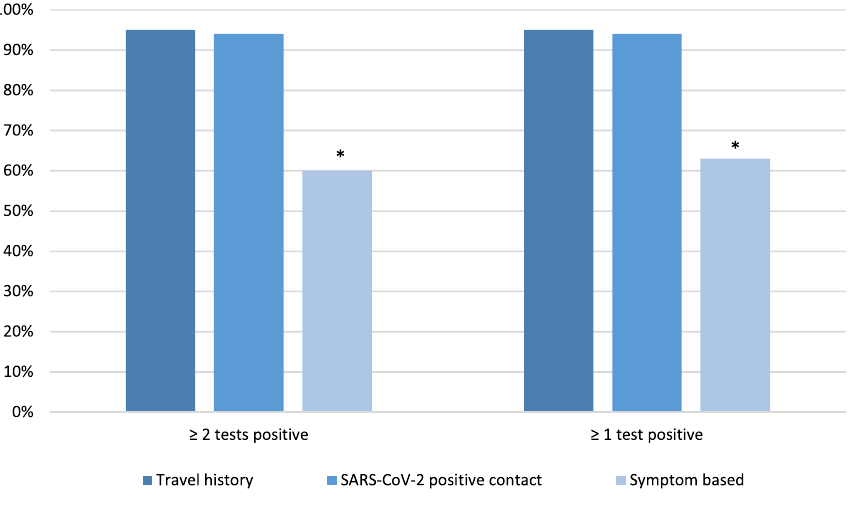
Figure 2. Factors influencing serpositivity; p value refer to comparison between travel history and symptom based test indication as well as between SARS-CoV-2 positive contact and symptom based test indication.